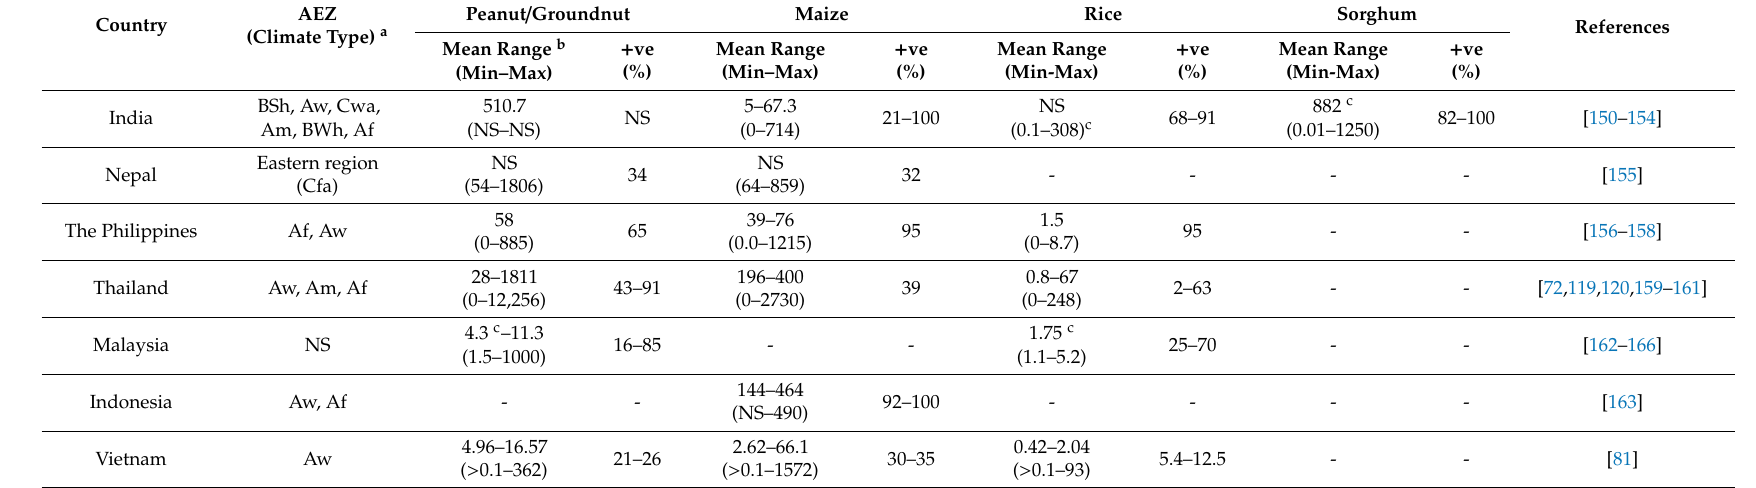
Table 6. Incidence and concentrations ( µ g / kg) of aflatoxin contamination of staple crops in selected countries from the Southeast Asian region. Data are for total aflatoxins (B1 + B2 + G1 + G2), unless otherwise stated in the footnotes.